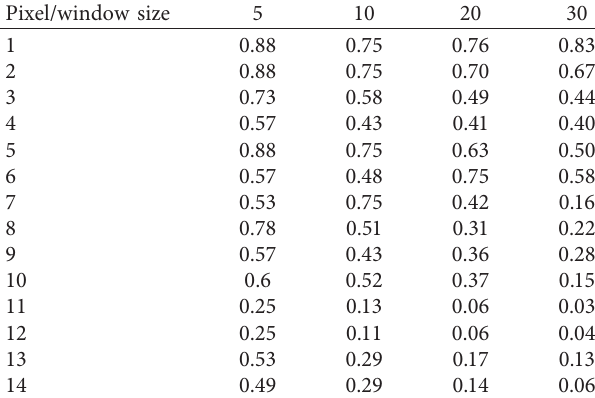
Table 1: F c value of percolation regions of different pixels in 100 resolution